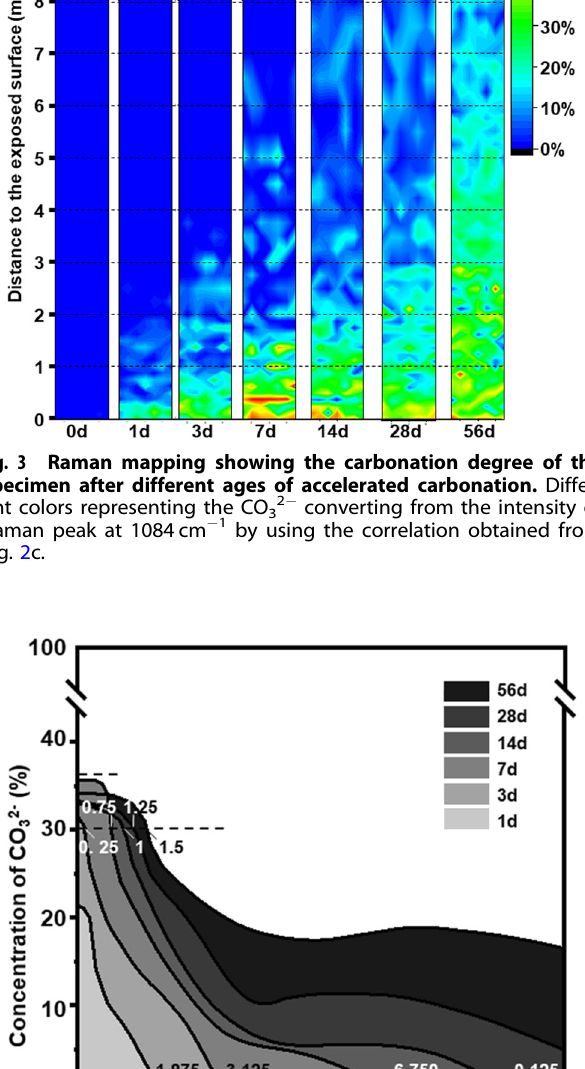
Fig. 3. From the CO 32 − content mapping results, evolution of the carbonation process and the development of carbonation at